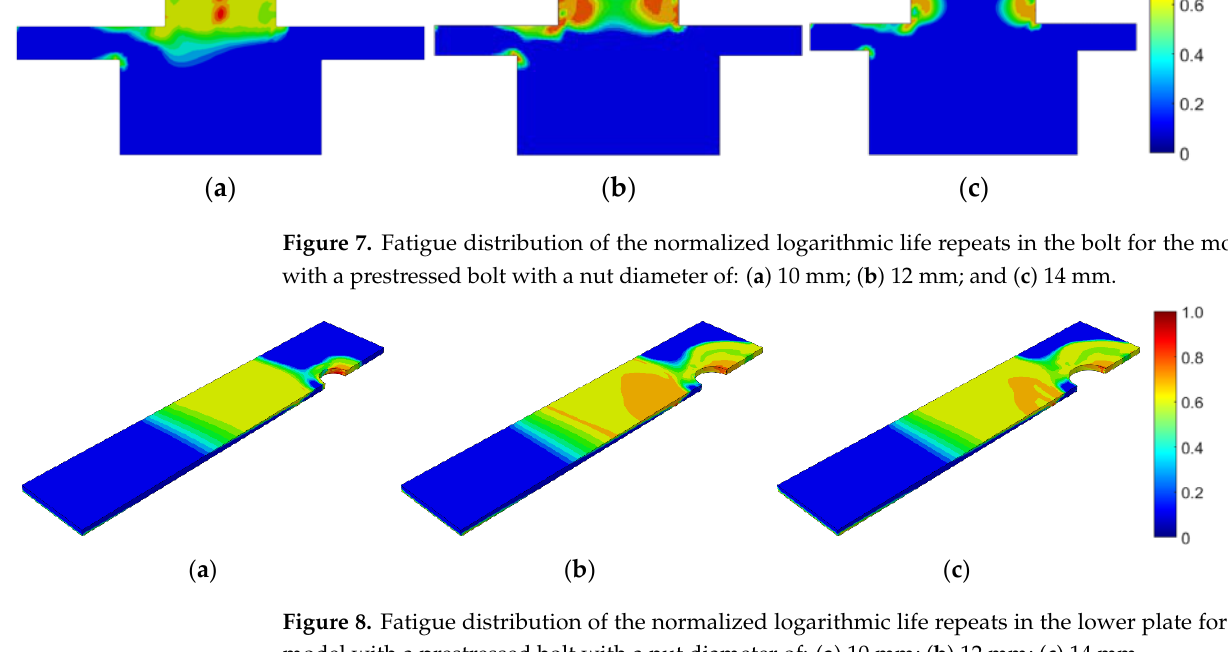
Figure 9. Fatigue distribution of the normalized logarithmic life repeats in the upper plate for the model with a prestressed bolt with a nut diameter of: ( a ) 10 mm; ( b ) 12 mm; ( c ) 14 mm.